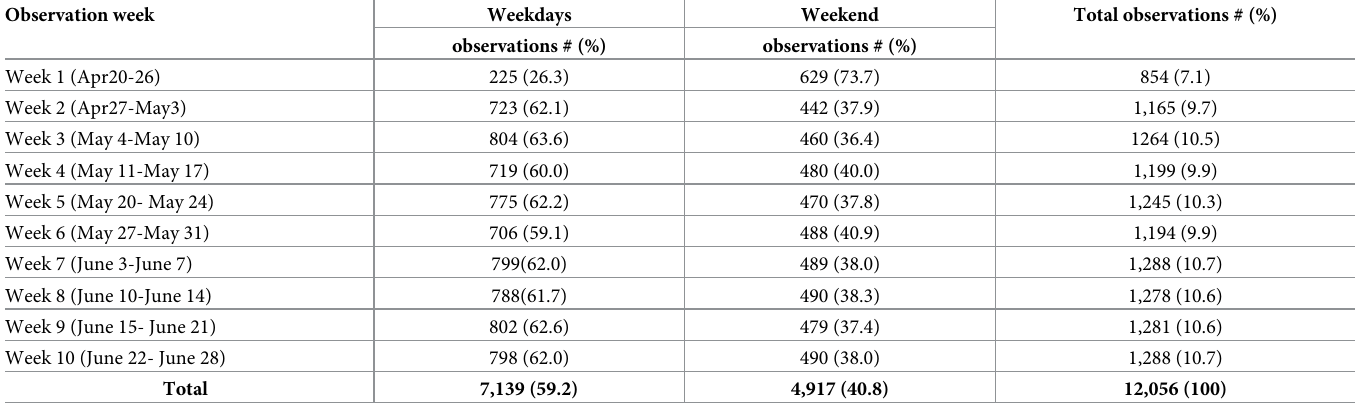
Table 1. Number of people observed (April 20– June 14, 2020, Addis